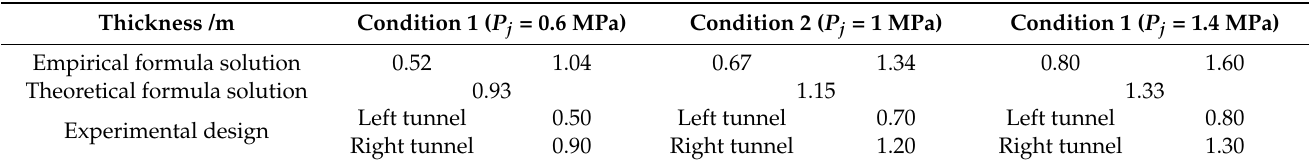
Table 4. Calculation of thickness of concrete retaining wall and test